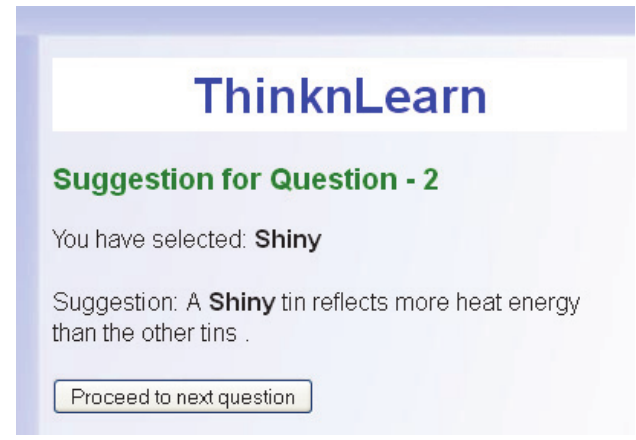
Figure 9 . Measurement and observation of Silver (Shiny) surfaced tin.